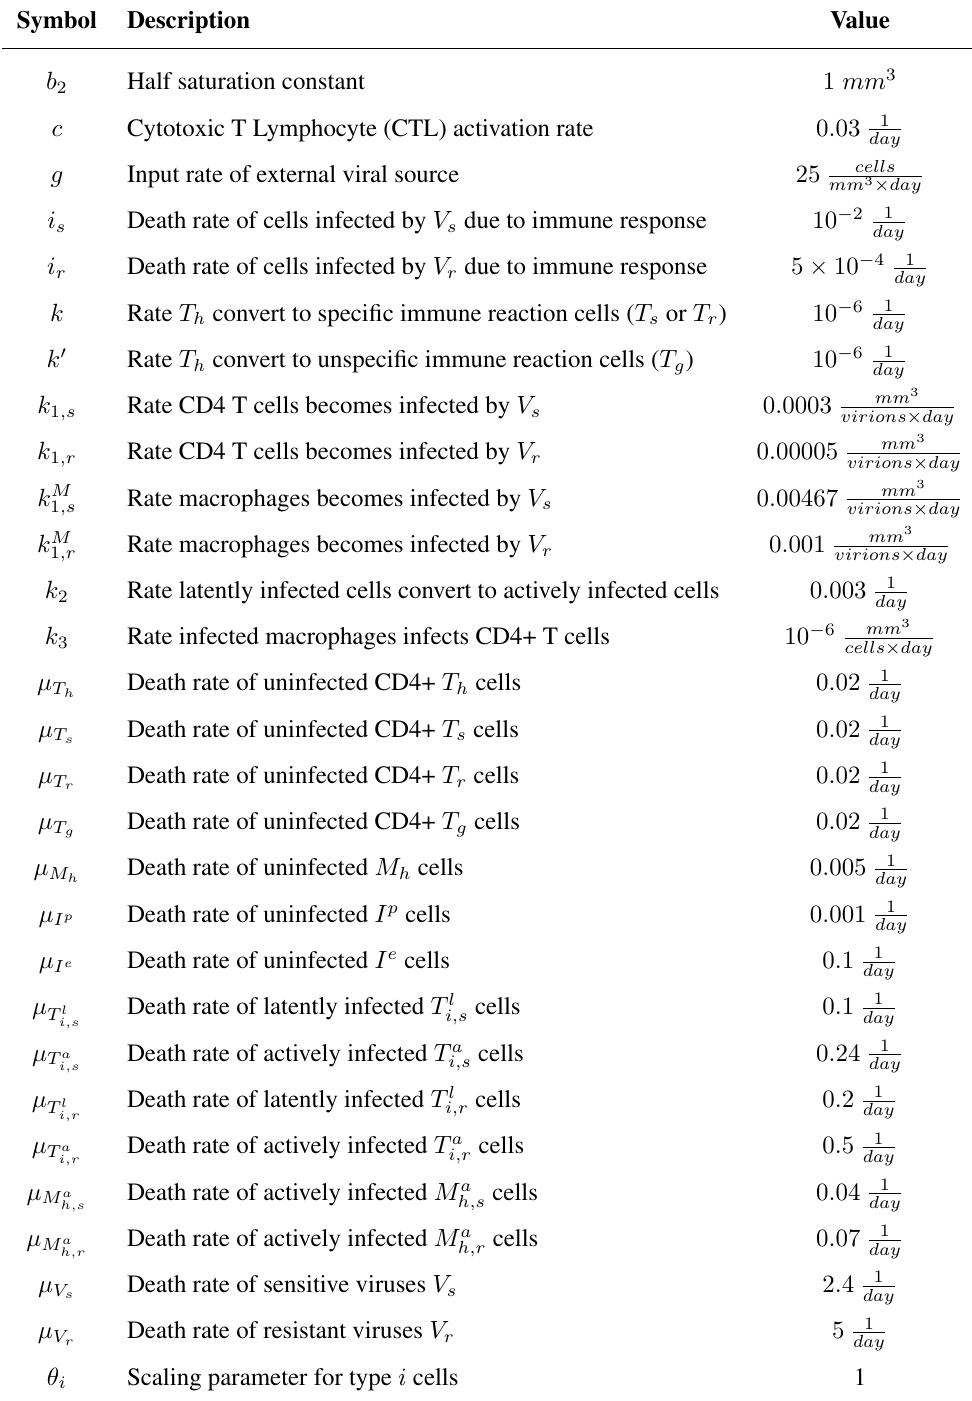
Table B2. Common parameters at both instances (Part